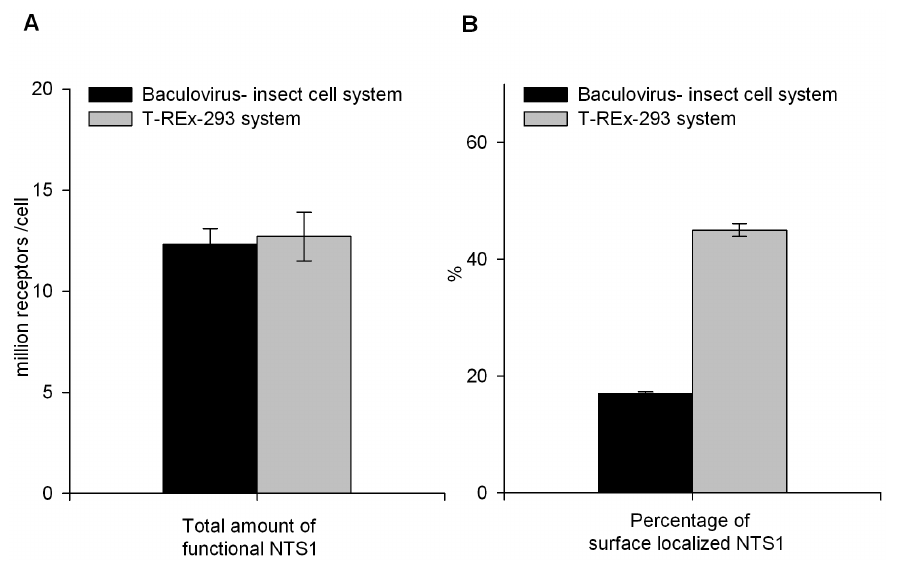
Figure 4. Expression of NTS1 in the transient insect cell system and inducible T-REx-293 system. (A) Total functional NTS1 numbers were determined by [ 3 H]NT binding assays using detergent solubilized cells (B) Surface localized NTS1 numbers were determined by [ 3 H]NT binding assays using intact cells and combined with data from (A) to calculate percentage of surface localized NTS1 (baculovirus insect cell system: 7 independent expression experiments; T-REx-293 system: 4 independent measurements on one 5L expression experiment). The expression of NTS1 in insect cells was conducted as described in Materials and Methods. Expression of NTS1 in the T-REx-293 system was induced by the addition of 2 m g/ml tetracycline and 10 mM sodium butyrate, with harvest and analysis 36 hours later.